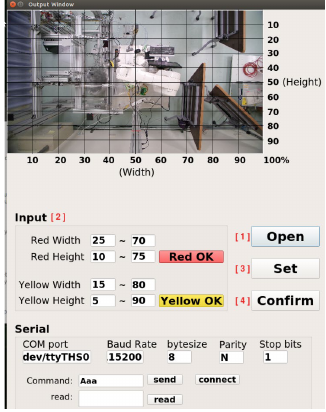
Figure 11. User interface after clicking the “open” button.